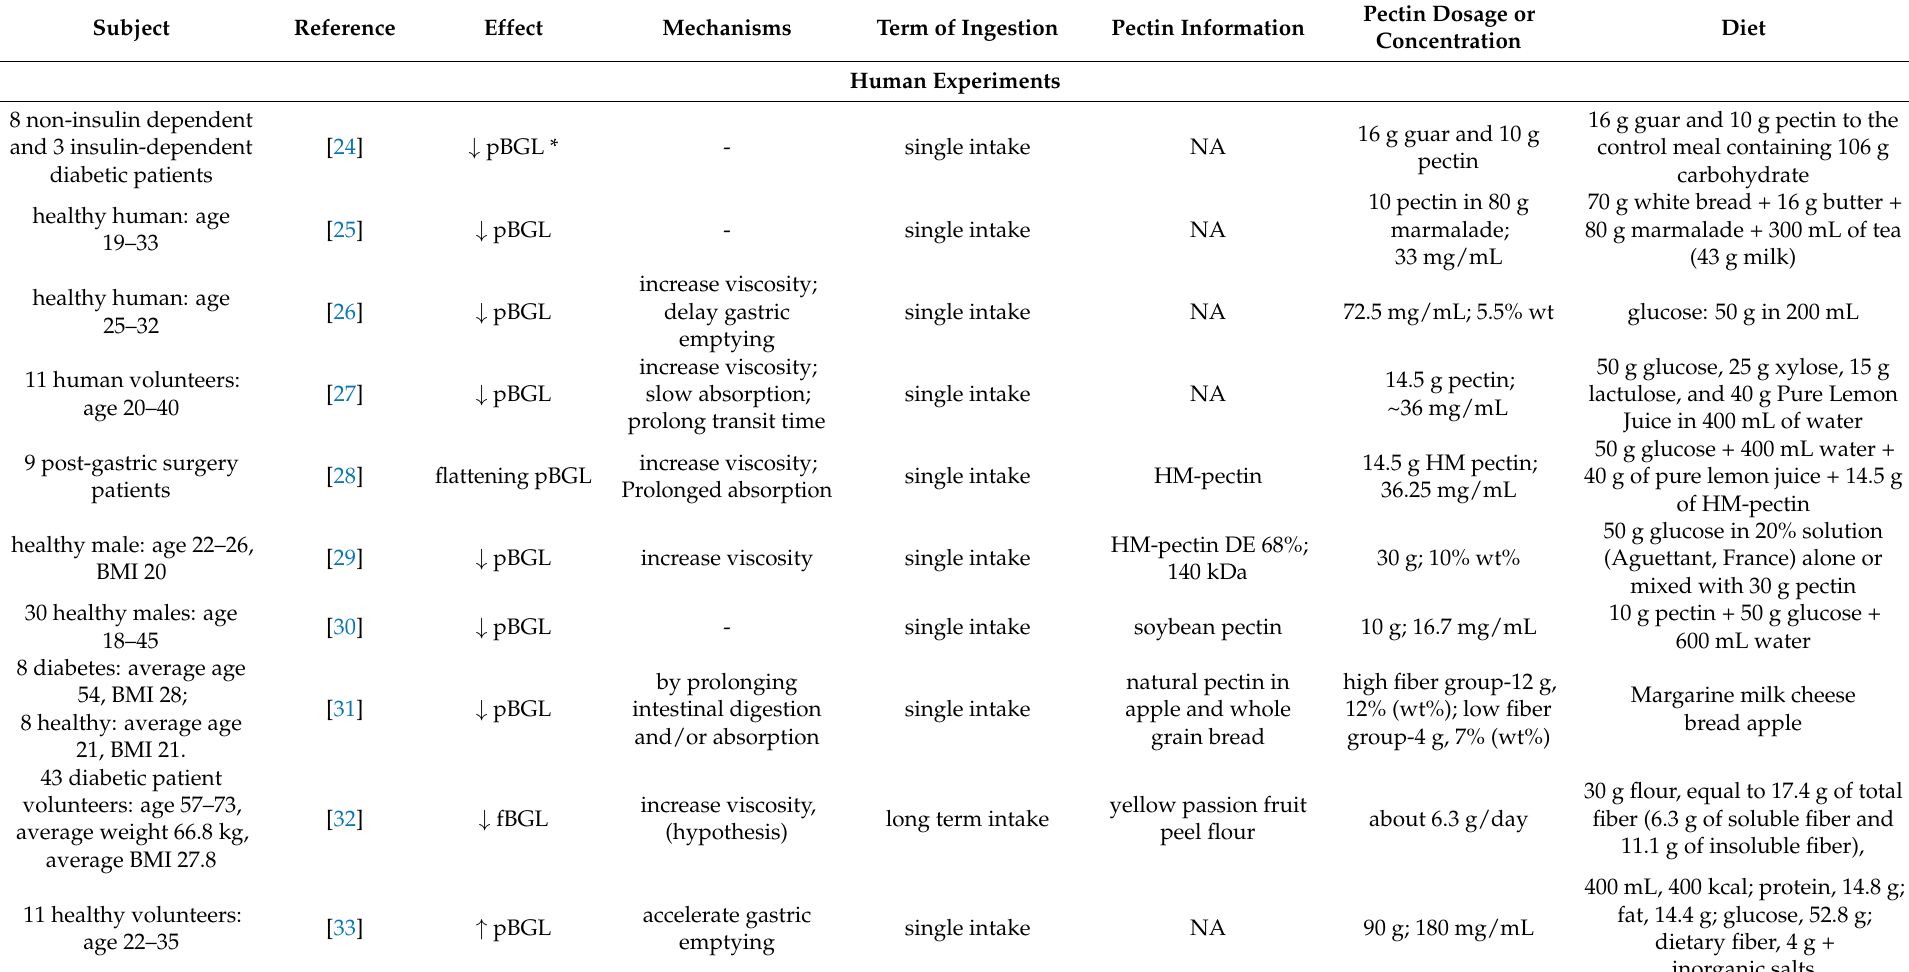
Table 1. Effects and mechanisms of pectin on postprandial and fasting blood glucose levels with human